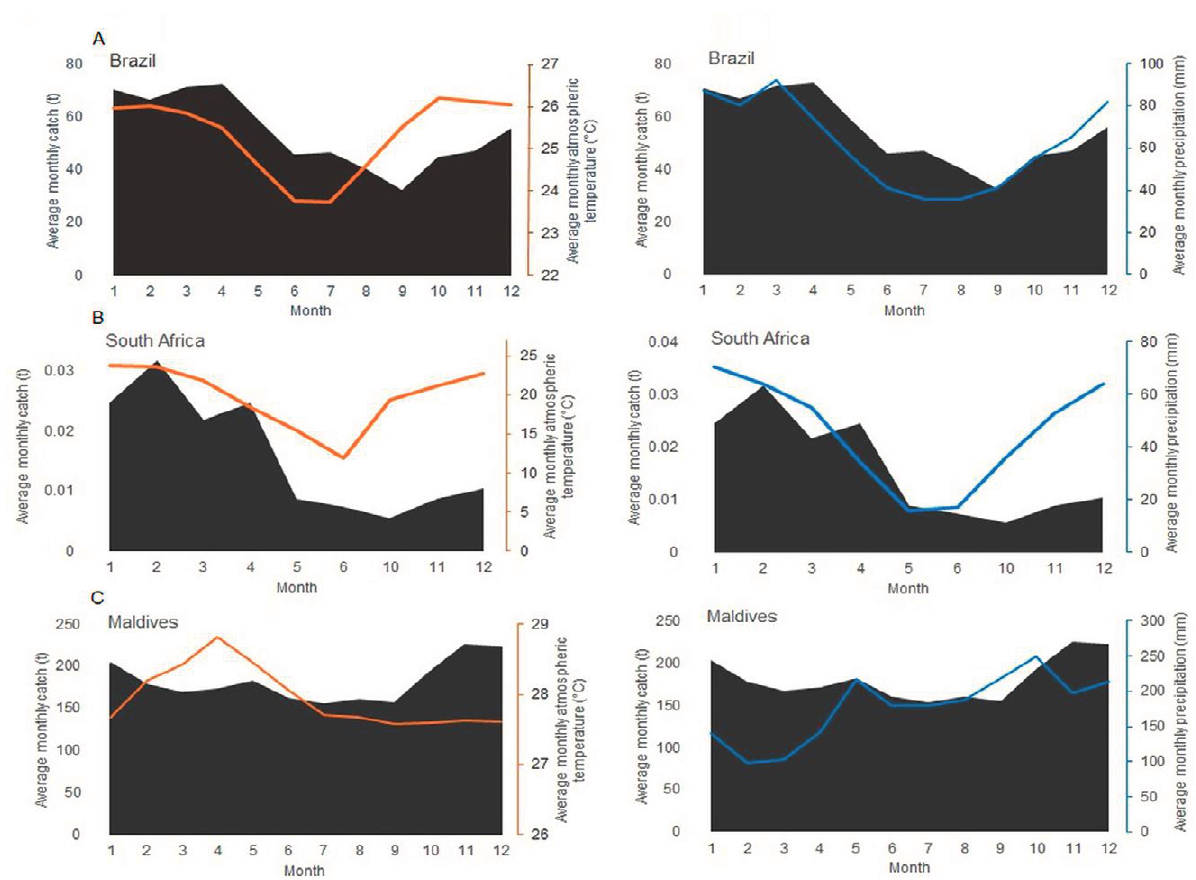
Fig. 8. – Average monthly skipjack catch (in t) in Brazil (A), South Africa (B) and the Maldives (C), overlapped by the average monthly temperature (in °C, orange curve), and the average monthly precipitation (in mm, blue curve).